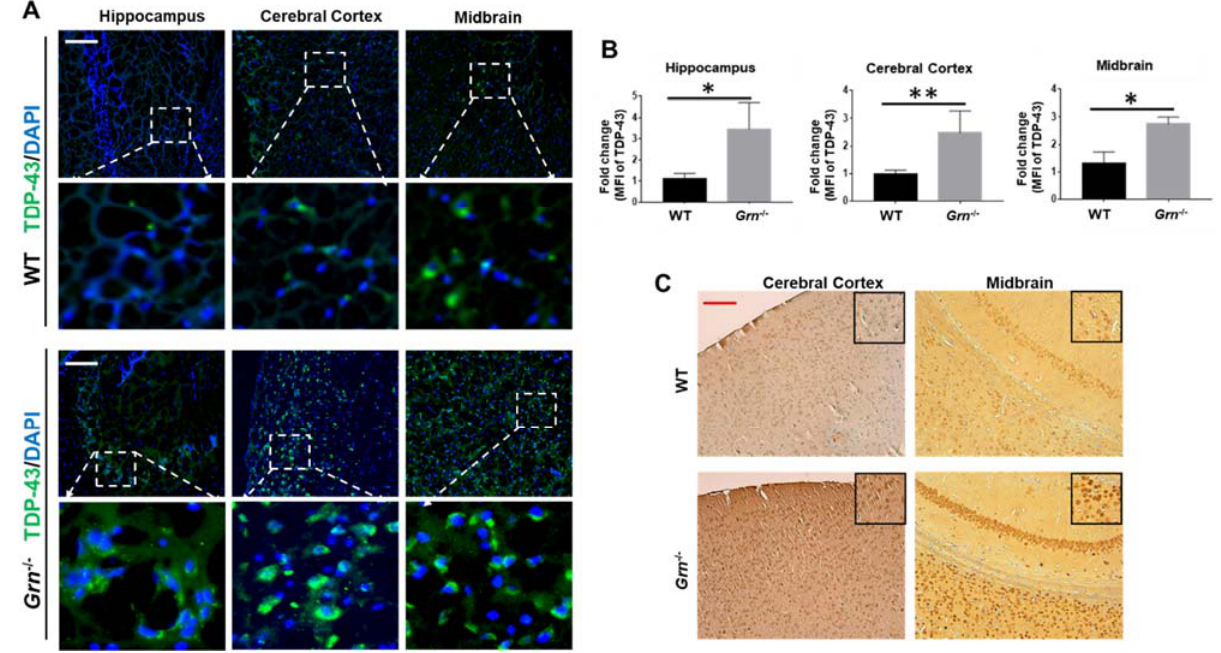
Figure 5. Accumulated TDP-43 in aged PGRN-deficient mice. Immunofluorescence and immuno- histochemistry staining of TDP-43 in the brain sections from 12-month-old WT and Grn − /– mice. ( A ) Representative images of TDP-43 accumulation in indicated brain regions by immunofluorescence staining. ( B ) Fold change of MFI of TDP-43 per section were quantified of A. ( C ) Immunohistochem- istry staining of TDP-43 in the deparaffinized brain sections of 12-month-old WT and Grn − /– mice. Scale bar: 100 μ m. n = 3. Data presented as mean ± SD. * p < 0.05, ** p < 0.01.